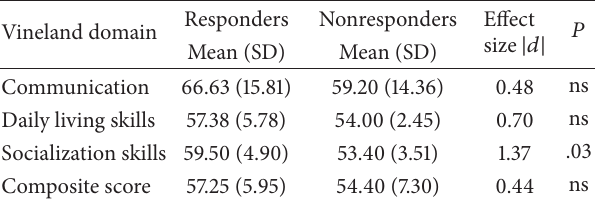
Table 4: Adaptive behavior standard scores for AUT group par- ticipants classified as RSA responders versus non-responders to proximal stranger